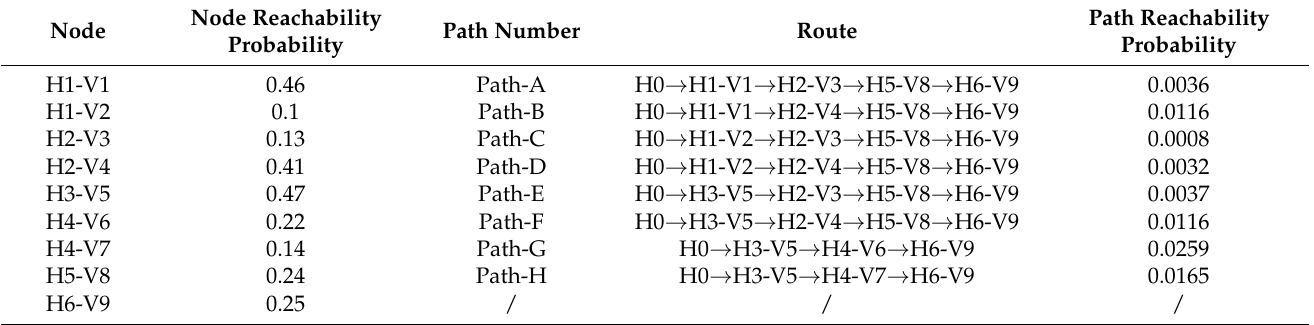
Table 3. Bayesian Attack Graph Node Reachability Probability and Path Reachability Probability.